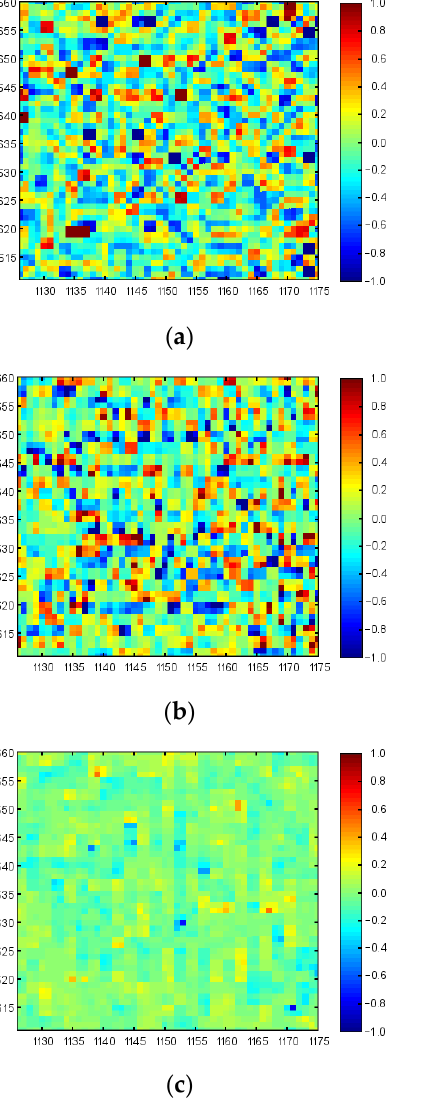
Figure 2. Coordinate distributions of the parameters of the Stokes vector S 1 ( a ) , S 2 ( b ) , S 3 ( c ) , and their corresponding histograms ( d – f ) of the object under investigation.